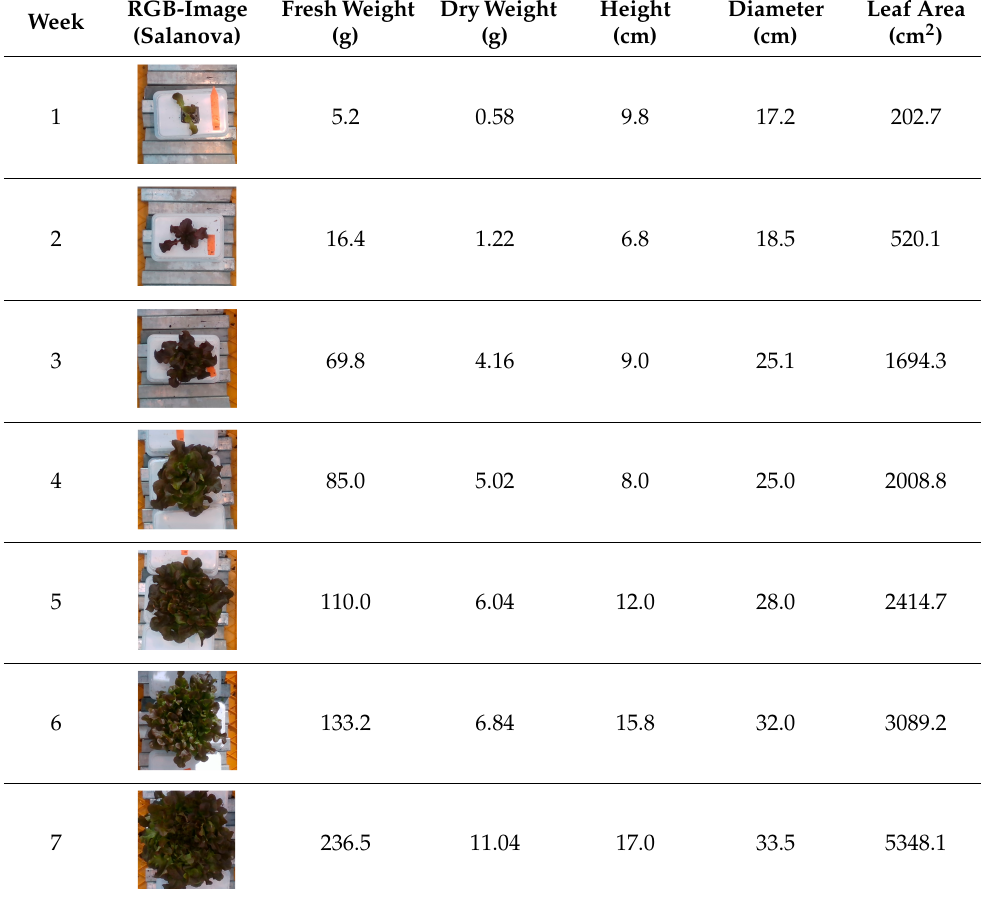
Table 1. Growth index data format for each RGB image of the lettuce measured using destructive